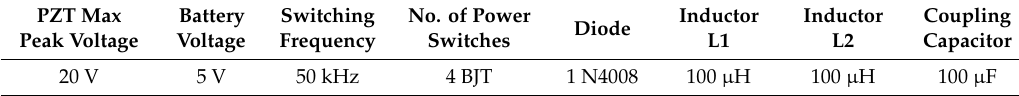
Table 1. Single-stage Zeta converter technical data. BJT, bipolar junction transistor.